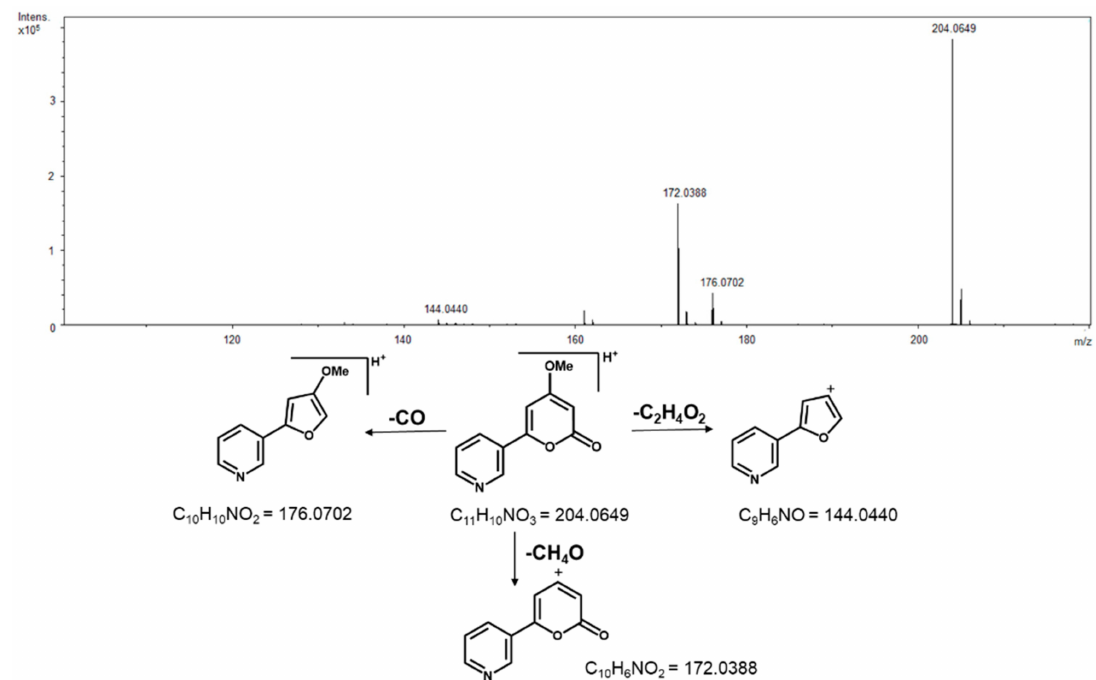
Figure 2. High resolution mass spectrum of anibine [M + H] + = 204.0649 and its fragmentation pathways. The separation of samples from RESEX was due to the presence of 6-styryl-2-pyrone (RT 19.30 min; m / z 199.0773) (Figure 3), which was previously isolated from A. parviflora leaves [16,17]. The fragment ion at m / z 171.0809 is due to the common loss of CO. The quasi-molecular ion detected in m/z 221.0581 is the sodium adduct of 6-styryl-2-pyrone.